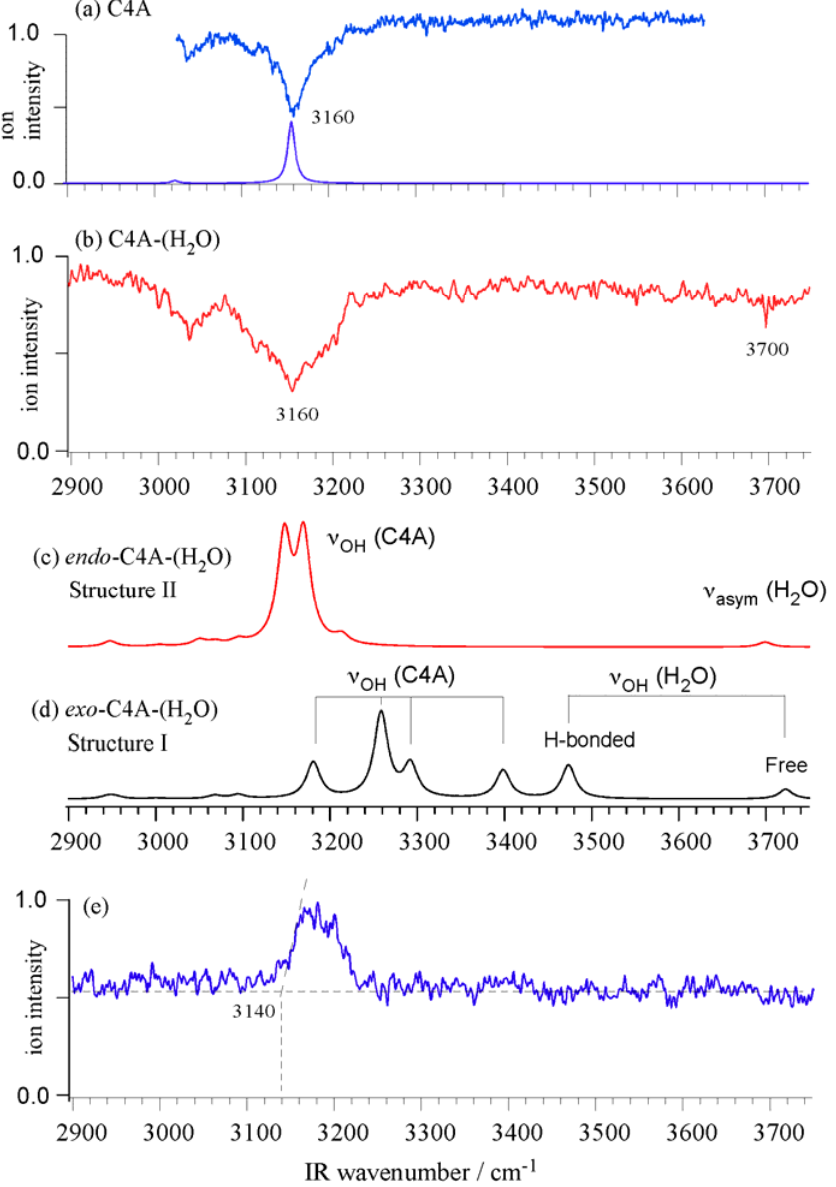
Figure 17. IR-UV dip spectra of (a) C4A and (b) C4A-(H (Structure II) and (d) exo -form of C4A-(H pVDZ level of theory. The calculated frequencies are scaled by 0.96. (e) IRPD spectrum of O). Figure adapted from Reference C4A-(H 2